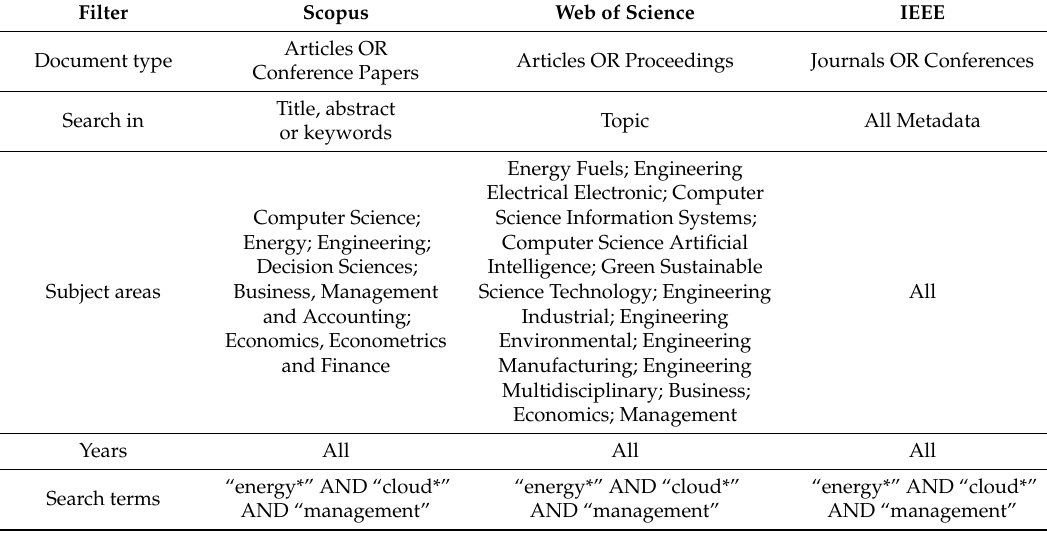
Table 1. Search filters.